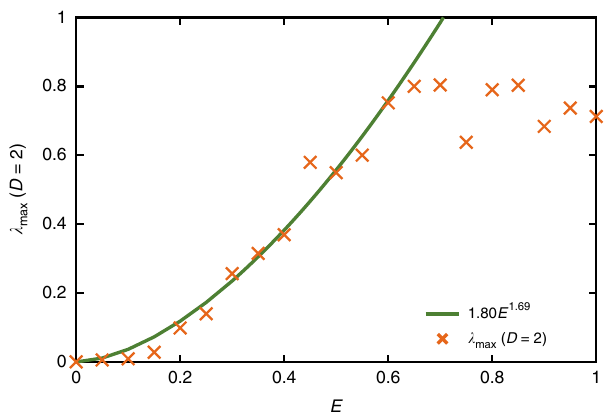
Fig. 3 Maximum Lyapunov exponent versus energy density. It has previously been conjectured that λ max ≤ 2 π k B T / ħ , here, we observe that λ D = 2) increases with energy density above the ground state, but max ( appears to saturated at E ≈ 0.6. The initial growth of λ max was fi tted with a